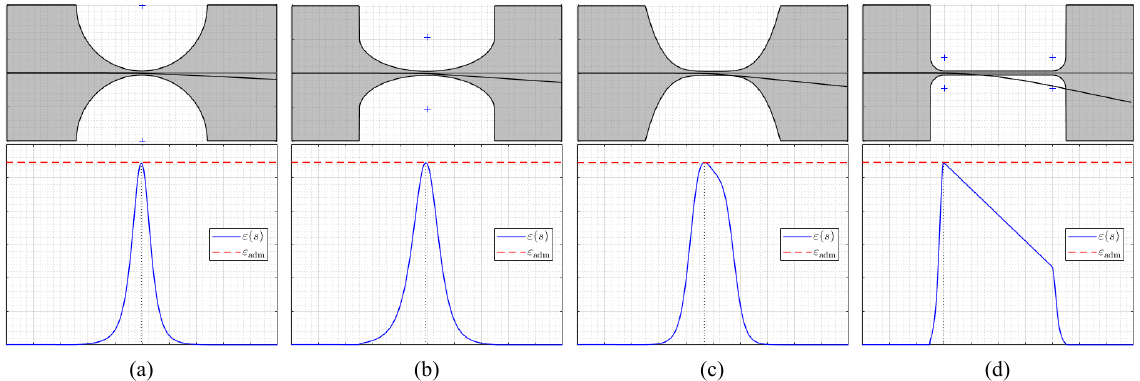
Figure 10. Example results of the deformed neutral axis and the outer fiber strain distribution for different force load inputs to equal ε adm = 0 . 5% ( β L = 2, β l = 1, β h = 0 . 03): (a) circular contour with | ϕ max | = 2 . 72 ◦ , (b) elliptical contour with | ϕ max | = 3 . 81 ◦ , (c) power function-based contour with n = 4 and | ϕ max | = 5 . 56 ◦ , (d) corner-filleted contour with | ϕ max | = 11 . 73 ◦